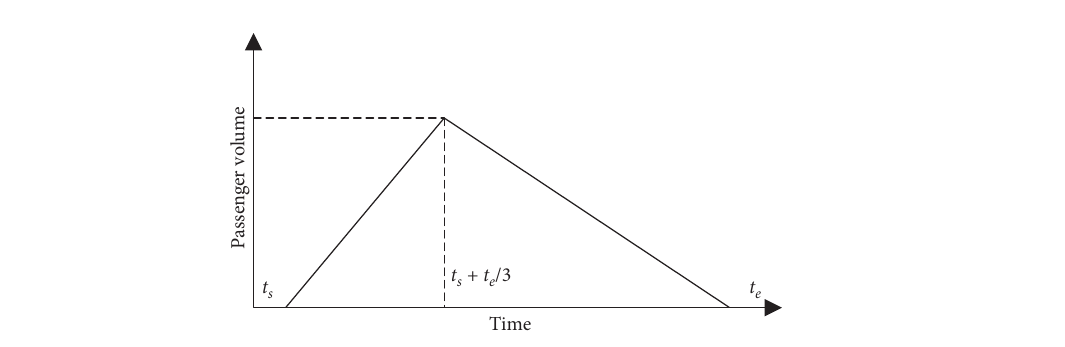
Figure 4: Temporal distribution of arrival passengers. Table 4: Performance comparison of Gurobi and TS